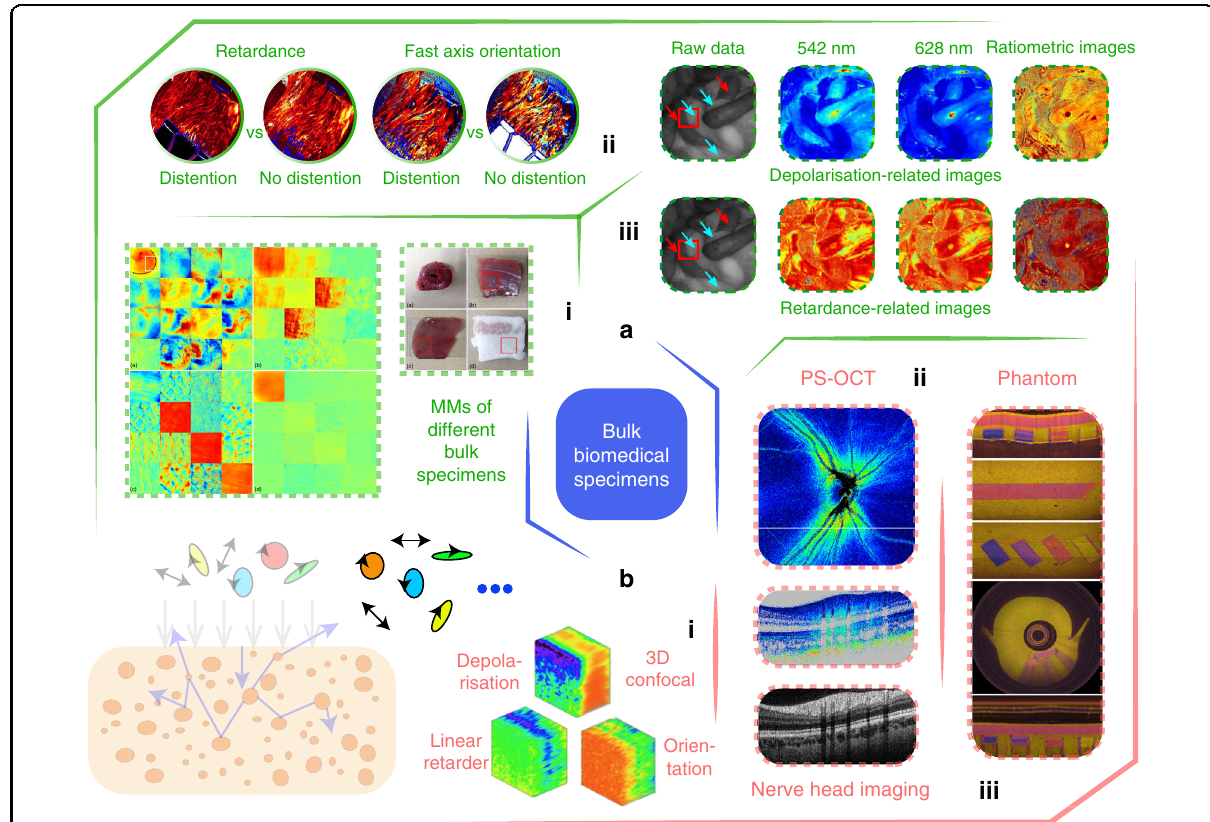
Fig. 7 Applications enabled via bulk specimen polarimetry (in vivo and ex vivo). a General backscattering-mode polarimetric imaging: (i) MMs and original sample images for several ex vivo bulk specimens 167 . (ii) Polarisation properties of ex vivo bladder tissue 256 . (iii) Polarisation properties using combined wavelength information for in vivo characterisation of rat abdomen tissue 92 . b Certain speci fi c backscattering-mode phantoms: (i) Full-depth MM confocal imaging of an unstained rat cornea 265 . (ii) PS-OCT imaging for a nerve head, which is conducted under the condition of in vivo eye imaging 34 . (iii) A birefringent phantom designed for bulk tissue research 270 . (a(ii)) Adapted with permission ref. 256 . CC BY 4.0. (a(i), a(iii), b(i), b(ii) and b (iii)) Adapted with permission from refs. 34,92,167,265,270 © The Optical